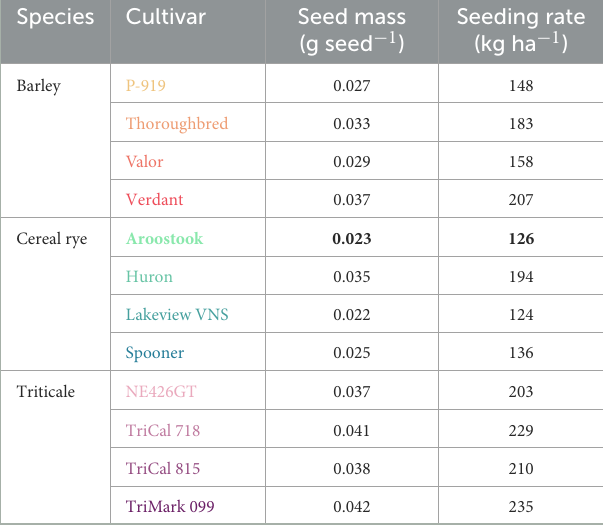
TABLE 1 Seed mass (g seed − 1 ) and the density-based seeding rate (kg ha − 1 , relative to the reference cultivar, “Aroostook” cereal rye) for all twelve winter cereal